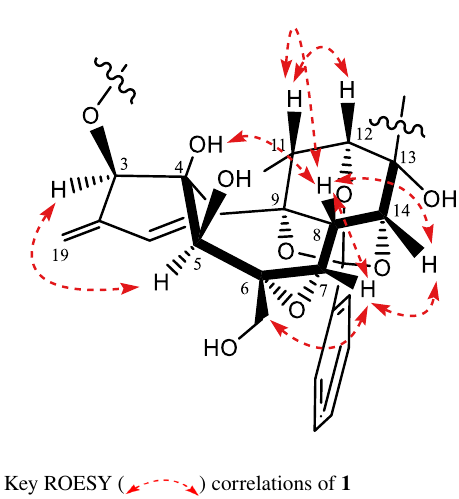
Fig. 3 Key ROESY ( ) correlations of